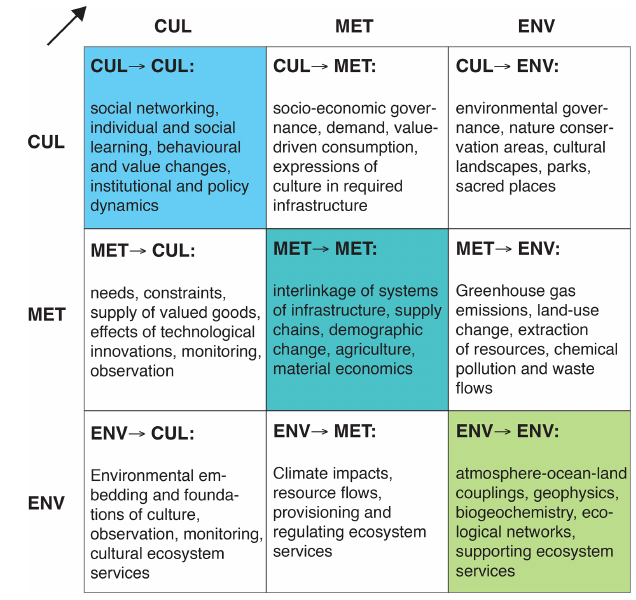
Figure 2. Taxonomic matrix for classifying directed interactions between subsystems in World–Earth systems models. This 3 × 3 classification system builds upon the taxonomy of three classes for subsystems introduced in Sect. 2. The unshaded matrix elements (here containing examples of interactions) correspond to the inter- action arrows drawn between the three subsystem taxa shown in Fig. 1. Shaded elements correspond to self-interactions. The exam- ples for directed interaction mechanisms given in the matrix ele- ments are indicative and based on our particular areas of